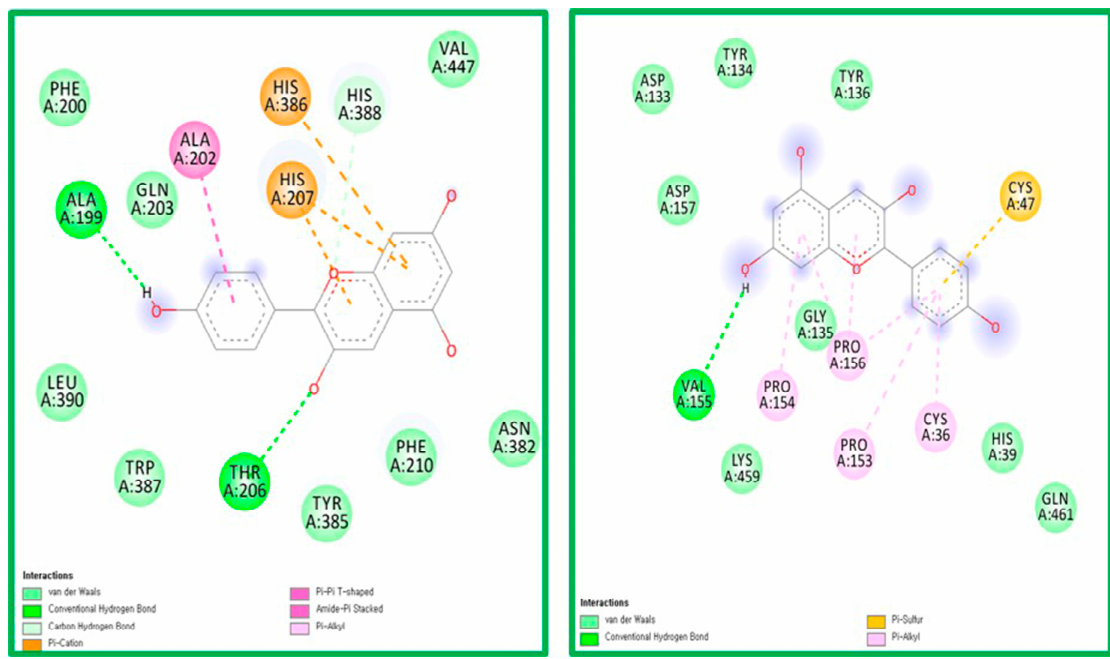
Figure 4. The ligand-receptor interaction screening of PG-COX-1 and PG-COX-2.